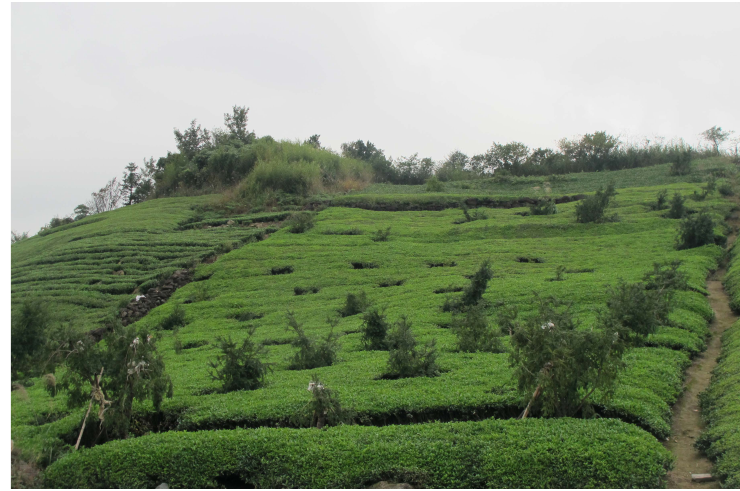
Figure 12. The interplanting of green tea and Chinese Torreya in Baiyankeng village (photographed by Zhao in September